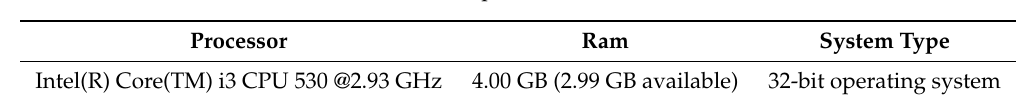
Table 5. Computer characteristics.